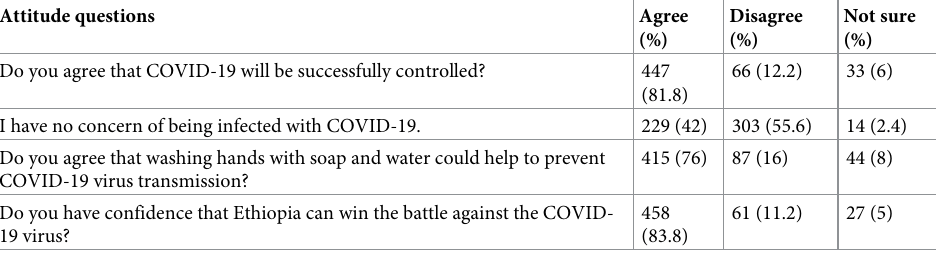
Table 3. Attitudes of the DBU students towards